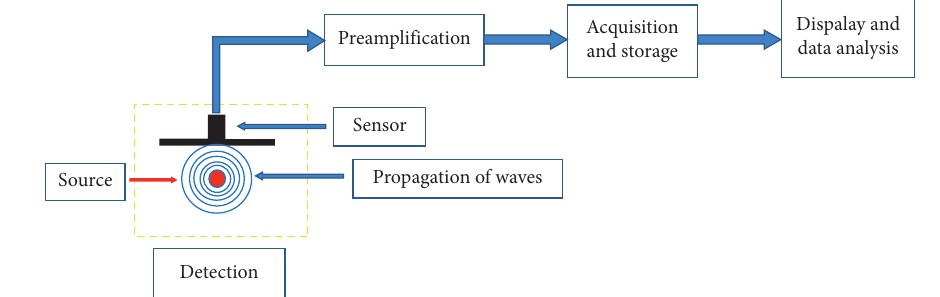
Figure 7: Schematic diagram of acoustic emission detection.